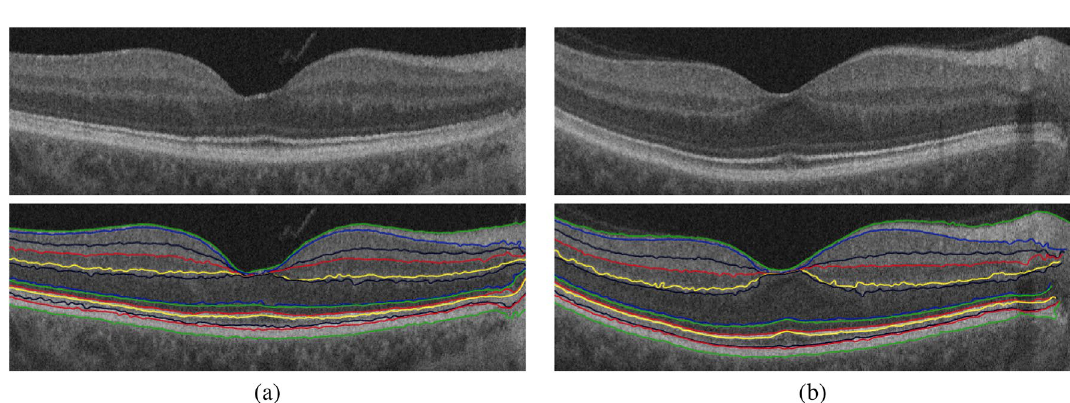
Figure 3. Sample example of the 12-layers segmentation for ( a ) a normal and ( b ) a DR case using our